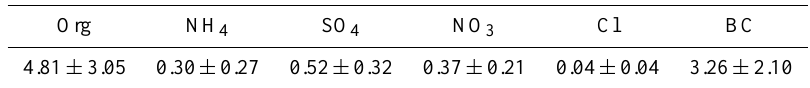
Table 2. Mean concentration ( ± standard deviation) for organics, NH 4 , sulfate, nitrate, chloride and black carbon concentrations (in µgm − 3 ) measured in São Paulo from 16 to 31 October